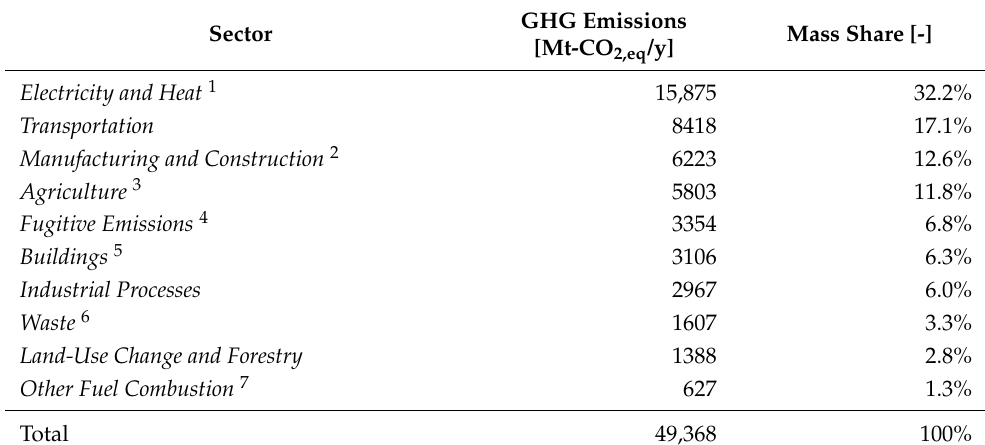
Table 1. World GHG emissions (2018) shared among production sectors (data from [3,7,8]). Sector